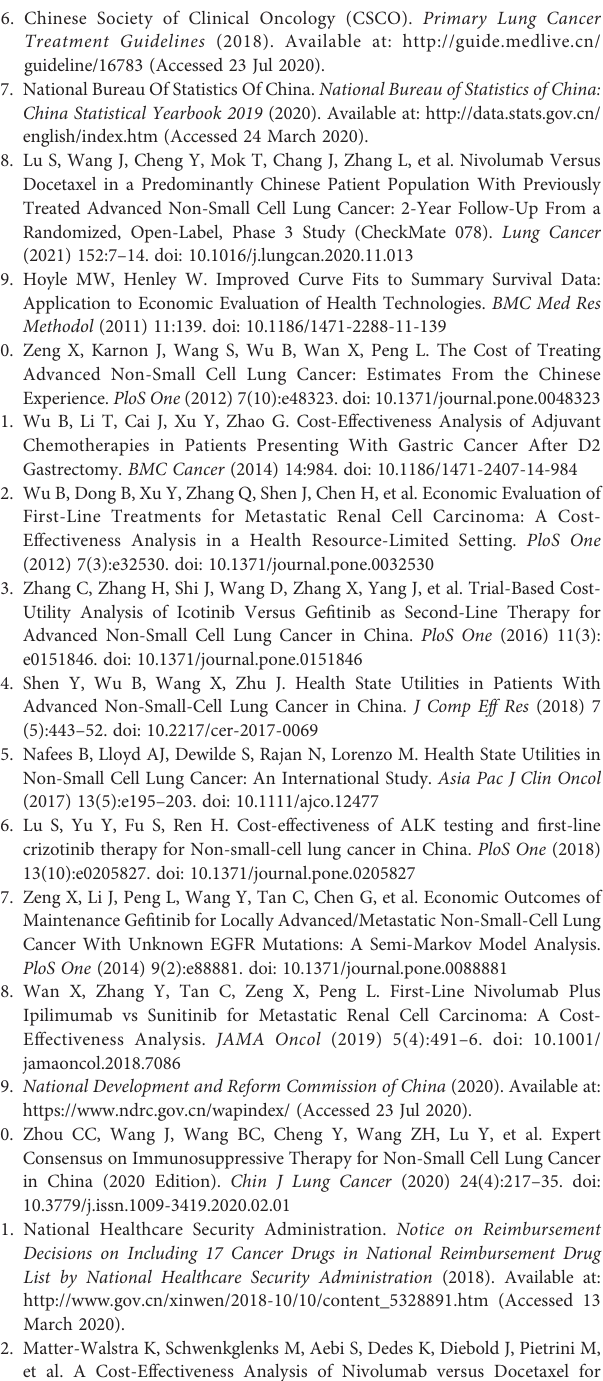
Supplementary Table 5 | The results of WTP threshold scenario analysis. The WTP threshold values used in the scenario analyses wereset onthe basisof the per Supplementary Table 6 | The results of the price reduction scenario analysis. The price reduction scenario analyses were conducted based on the price of nivolumab discounted ranging from 30% and